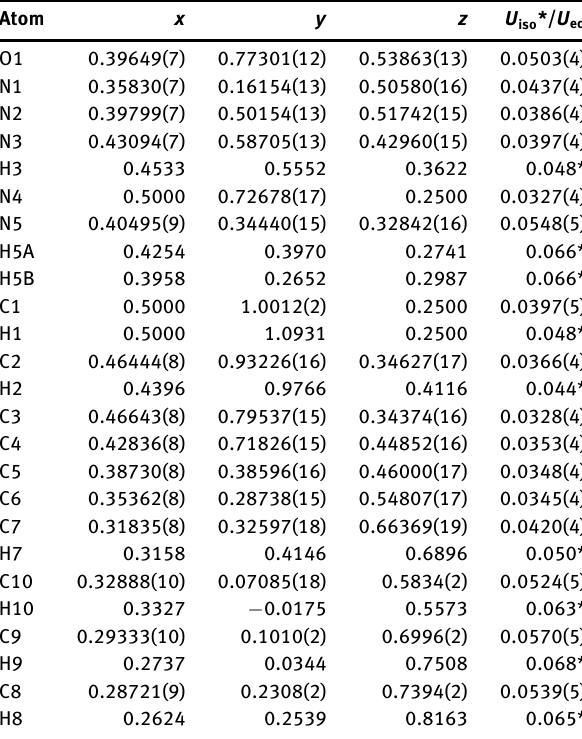
Table 2: Fractional atomic coordinates and isotropic or equivalent isotropic displacement parameters (Å 2